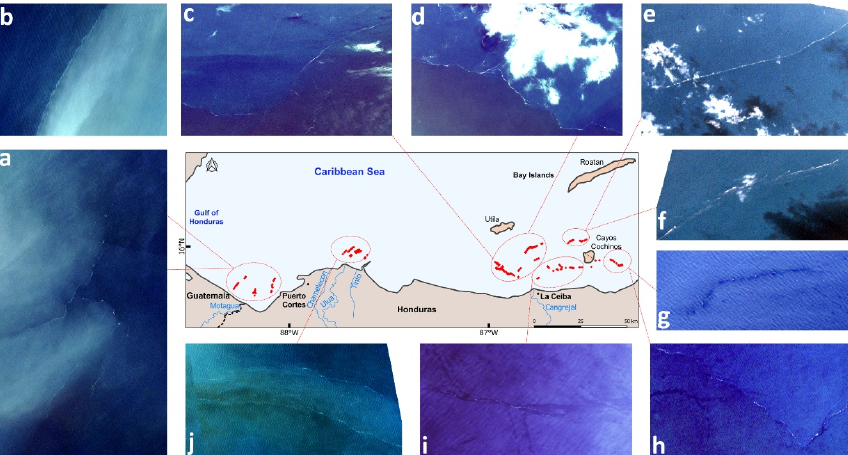
Figure 2. The detected plastic debris (red dots in the map) and snapshots of the corresponding satellite images at the Gulf of Honduras and Bay Islands during late September–October 2017. ( a , b ) Planet images with the detected plastic debris from the Motagua River on 27/9/2017. ( c , d ) The location of the detected debris on 15/10/2017. ( e , f ) Two days afterwards (17/10/2017), debris reached Cayos Cochinos island. ( g ) Debris trails were detected (9/10/2017) on a Sentinel-2 image. ( h ) Same as ( g ) but on a Planet image. ( i ) Debris detected on 7/10/2017 indicating that River Cangrejal also contributes to plastic pollution. ( j ) Planet data (27/9/2017) with the detected plastics originating from the Chamelecon, Ulua and Tinto rivers.